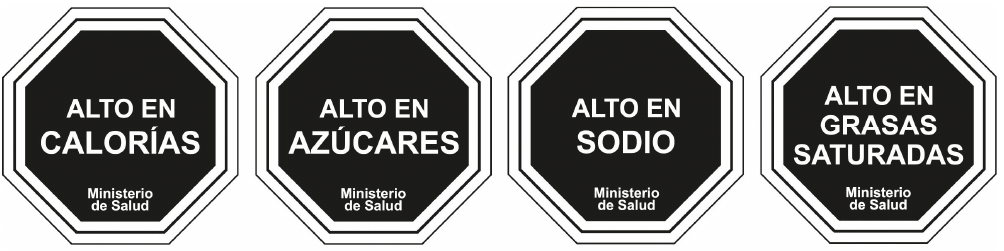
Figure 2. Example of a front-of-package (FoP) nutrient warning label system from Chile. In English, the labels say, “high in calories,” “high in sugars,” “high in sodium,” and “high in saturated fats,” respectively, with “Ministry of Health” noted at the bottom.